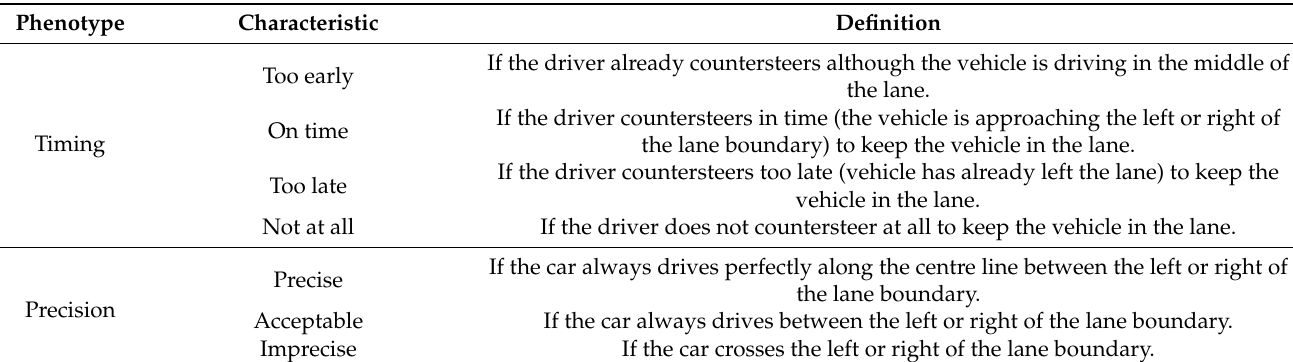
Table 2. Definition of the timing and precision characteristics using the lane-keeping function as an